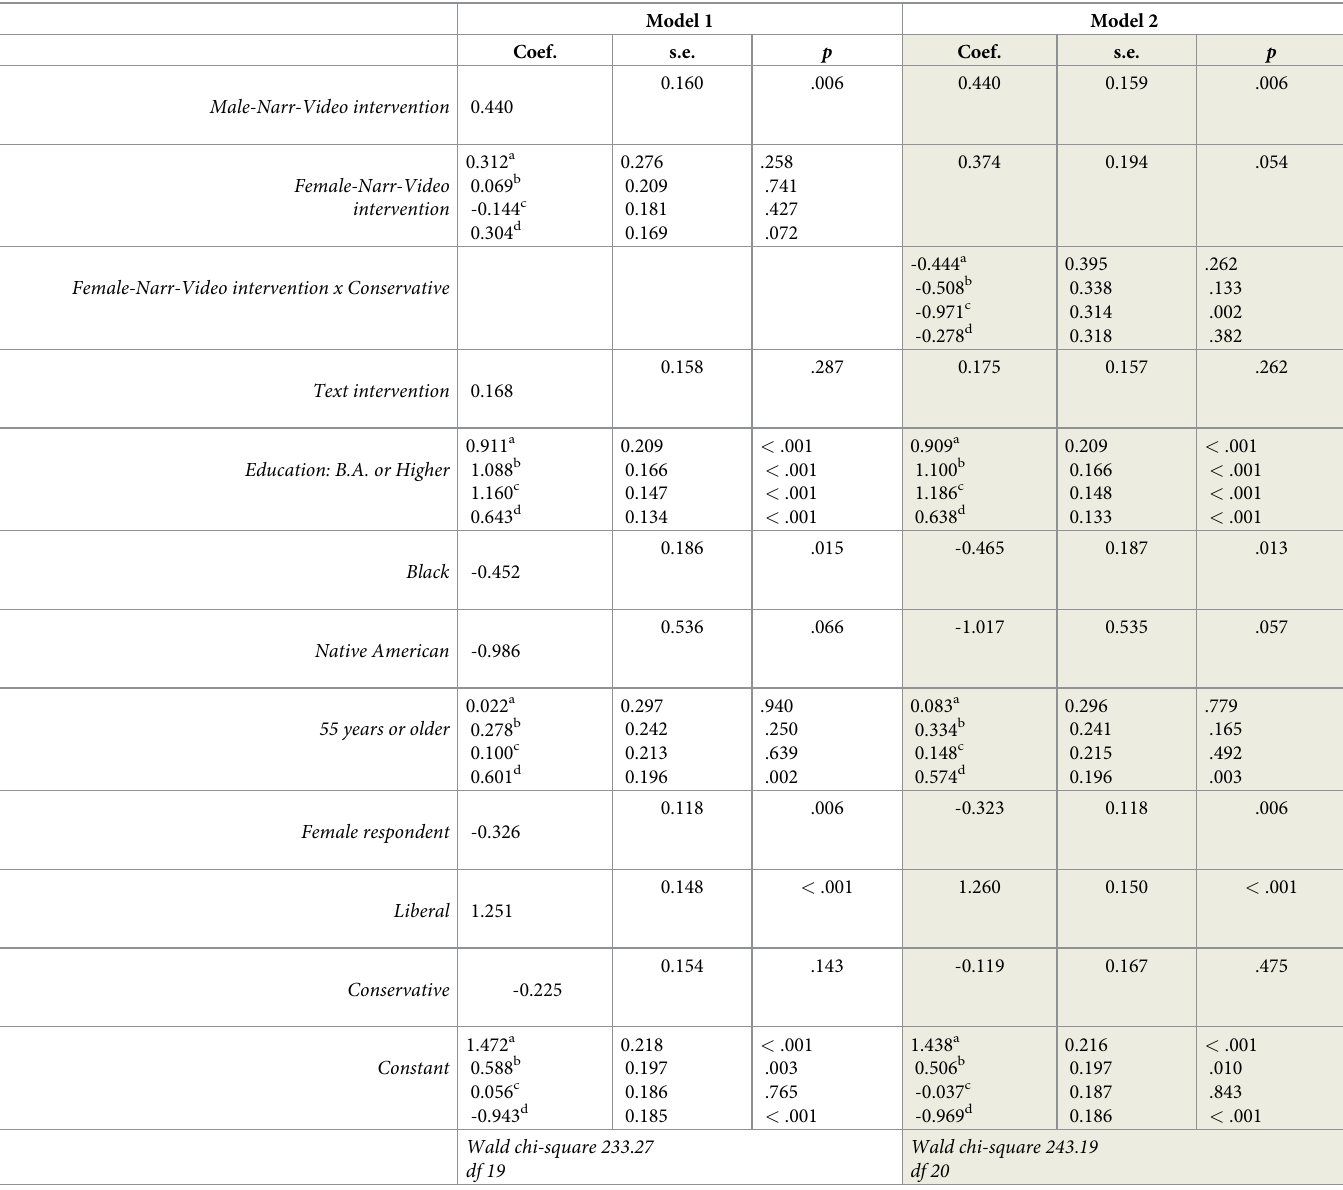
Table 1. Partial proportional odds ordered logit models for intention to